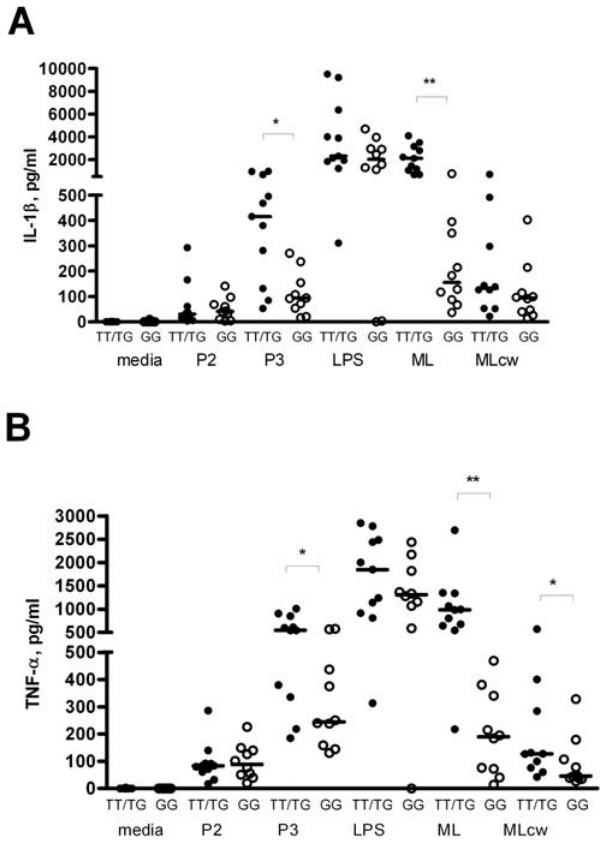
Figure 3. IL- b and TNF- a production in human mononuclear cells following stimulation with M. leprae . Peripheral blood mononuclear cells were stimulated for 18 hours and supernatants were assayed for cytokine production by luminex multiplex bead assay. PBMCs were obtained from 11 individuals with the genotype 1805TT or 1805TG (TT/TG: dark circles) and 10 individuals with the 1805GG genotypes (GG: open circles). PBMCs stimulated with media, PAM2 at 75 ng/mL (P2), PAM3 at 75 ng/mL (P3), or LPS at 10 ng/ml (LPS), whole irradiated ML at 20 m g/ml (ML) or MLcw at 10 m g/ml (MLcw). IL-1 b production following stimulation is shown in (A), and TNF- a production in (B). The mean level and standard error of the mean are depicted and were derived from averaging the responses of individual within each genotype group. The median level is depicted by a bar; *p # 0.05, **p # 0.001 by Mann–Whitney